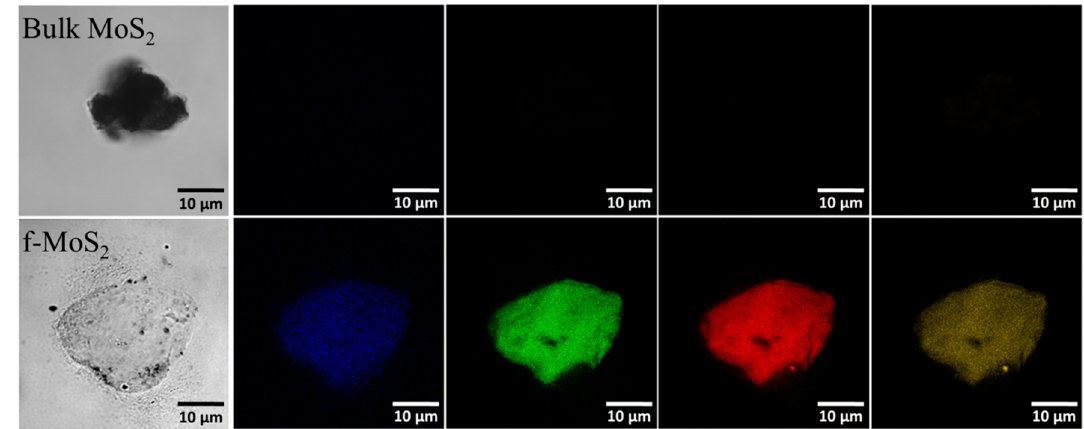
Figure 3. Confocal images of bulk MoS 2 and exfoliated f-MoS 2 nanoplatelets excited from 400–700 nm range (Blue to Far-red).